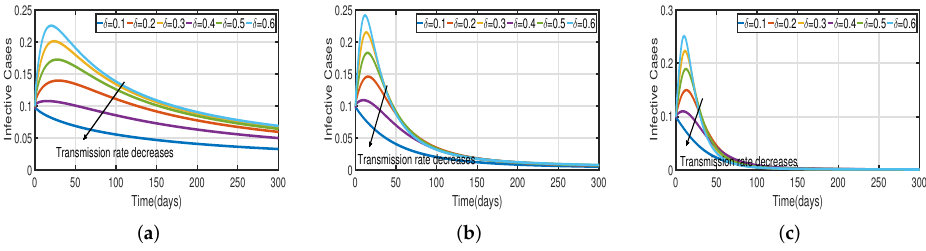
Figure 11. The trend of infected individuals regarding different transmission rates δ without a vaccination rate. ( a ) Fractional-order α = 0.62. ( b ) Fractional-order α = 0.83 ( c ) Fractional-order α =